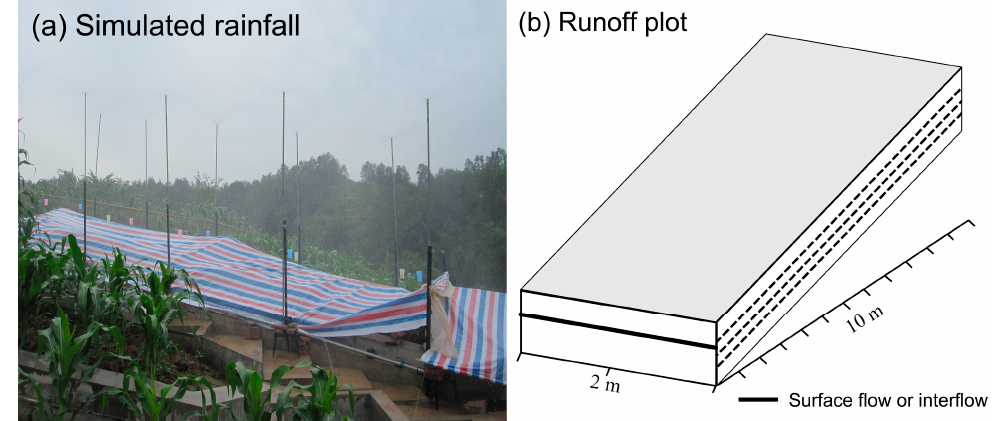
Figure 1. Location of the study area. 2.2. Experimental Design